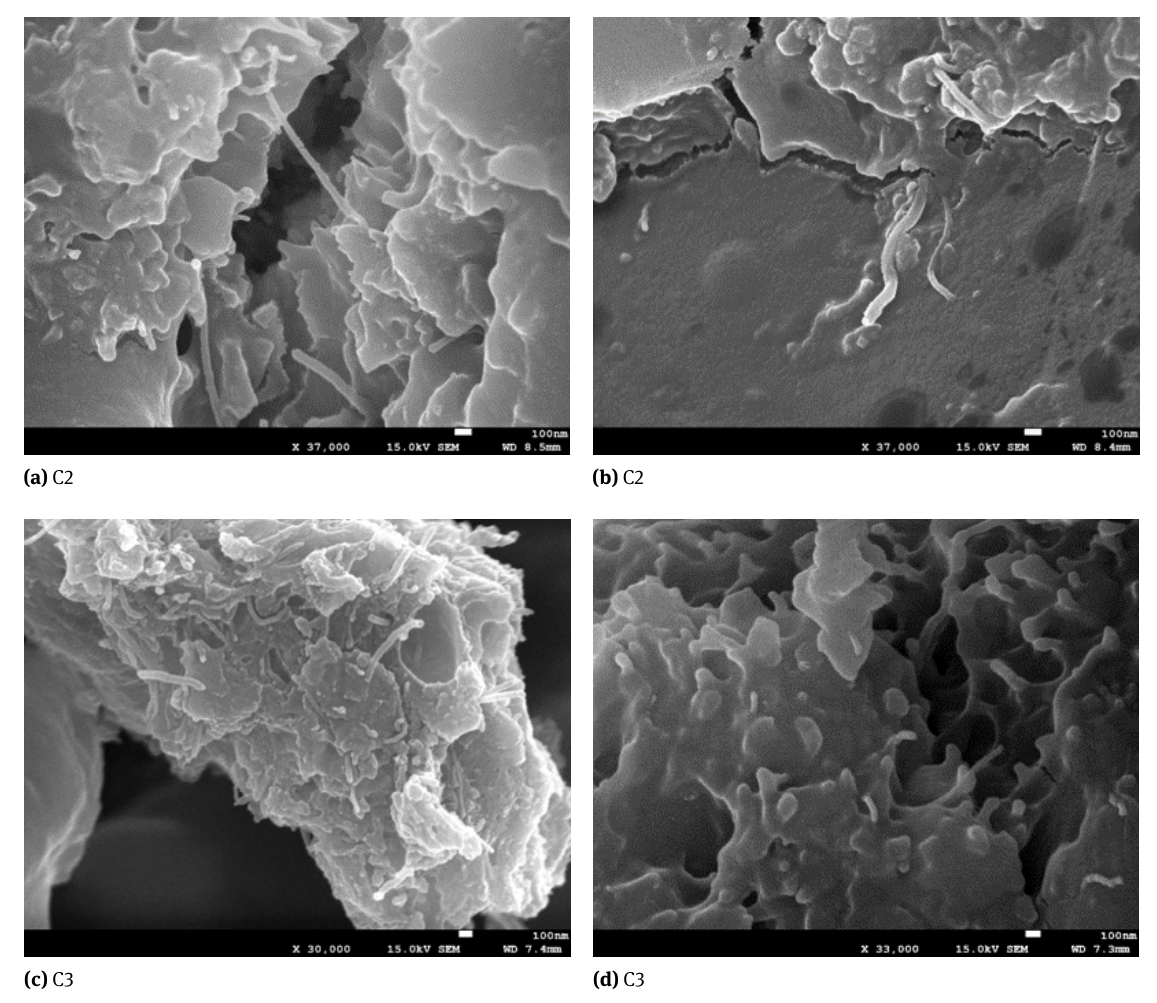
Figure 16: SEM image of CNT-reinforced